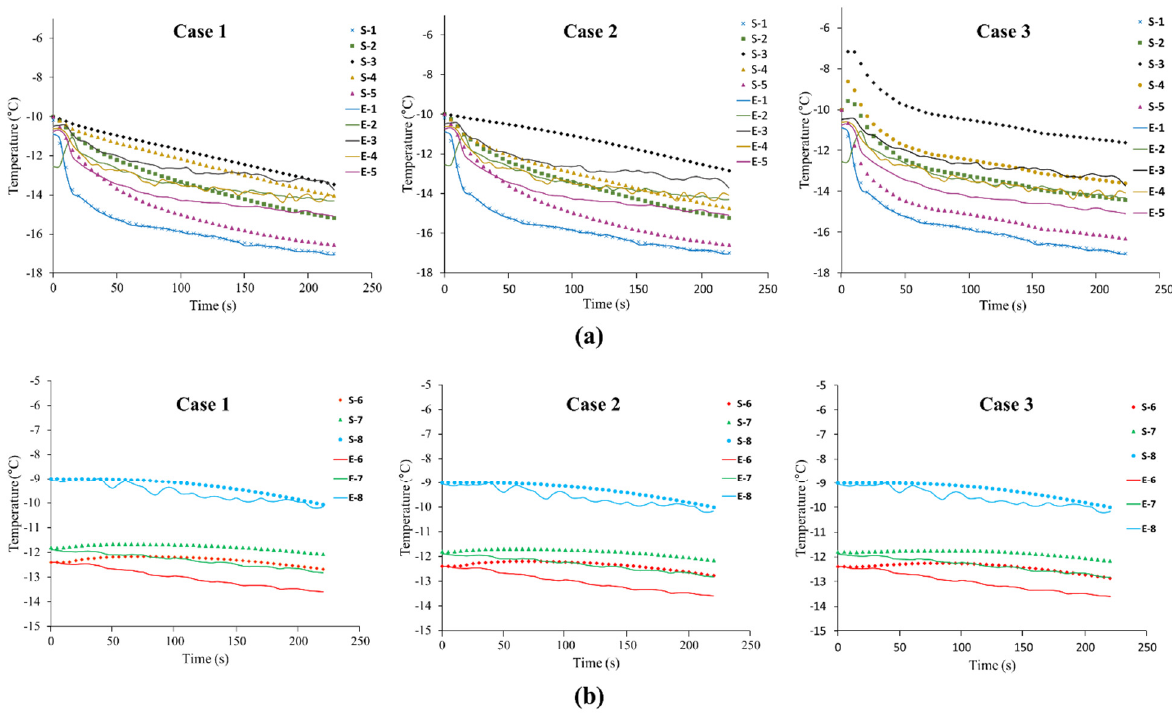
Figure 10. Comparison of experimental and simulated results (case 1, 2, and 3) for loading pattern (1): ( a ) temperature values in refrigerated body and ( b ) three boxes. Table 2. Temperature values according to the point inside the refrigerated body and boxes at 220 s. Simulation